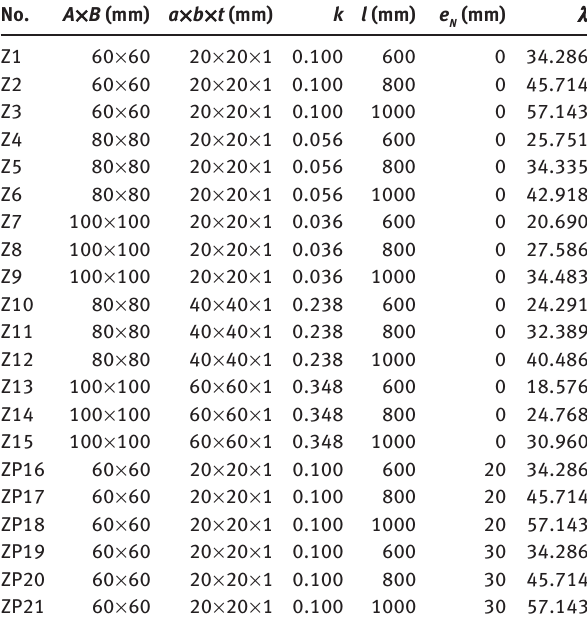
Table 1: Specimen parameters.